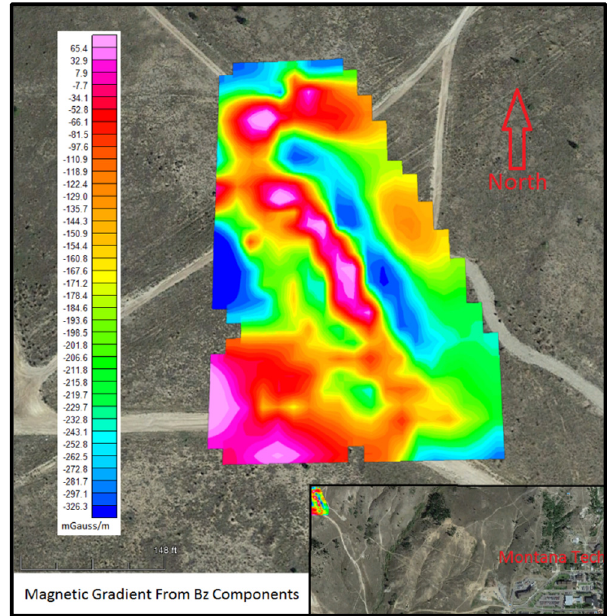
Figure 7. The magnetic gradient calculated from magnetic z direction (vertical) of the fluxgate magnetometers. The magnetic data is overlain on aerial imagery. The inset map at the bottom right shows the survey’s proximity to Montana Technological University.